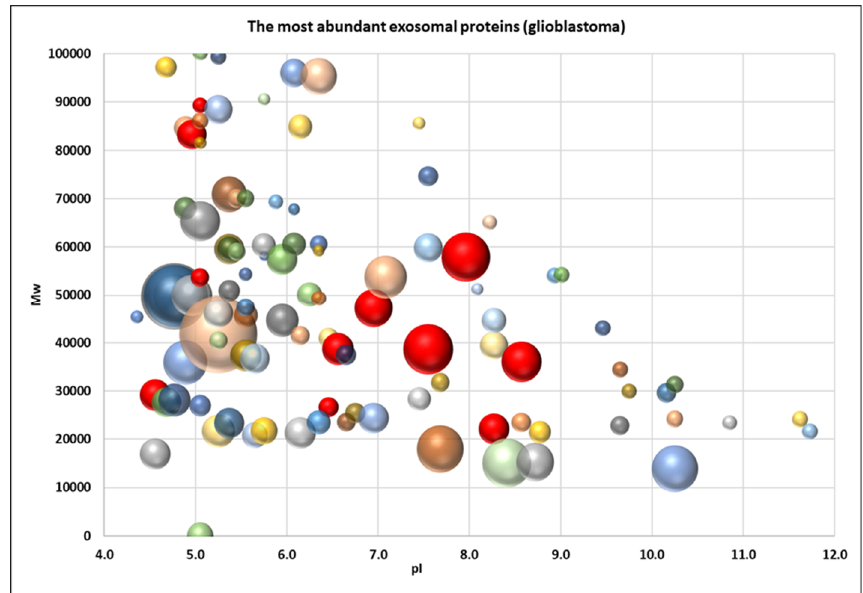
Figure 6. Virtual 2DE of the common exosomal proteins (Supplementary Table S1). Each ball represents a detected protein. The coordinates are pI/Mw, and the ball size is proportional to emPAI. The red balls represent proteins that are overexpressed in glioblastoma cells: KPYM, ANXA1, TPIS, VIME, ANXA2, TERA, ENOA, PRDX1, G3P, HS90B, 1433E.